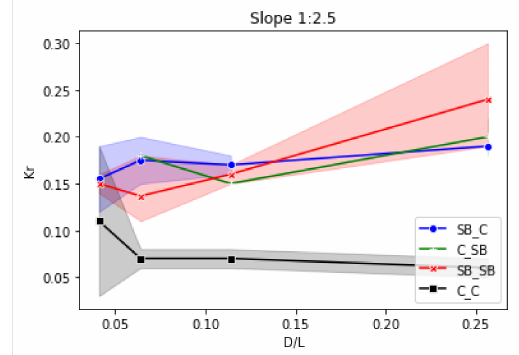
Figure 11. Kr vs. D/L for slope 1:2.5.